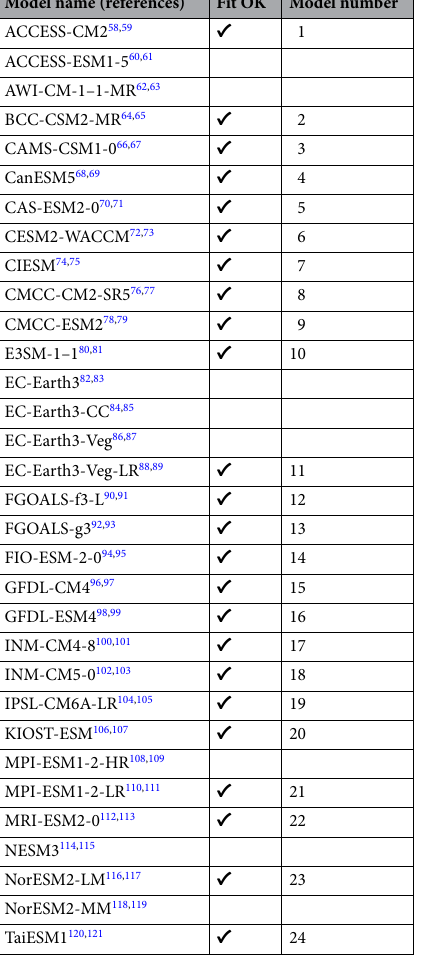
Table 1. List of CMIP6 climate models used in this study. Checkmarks indicate the climate models which are fitted by the stochastic model appropriately well. More detailed information on CMIP6 models, their components and parameterizations can be found at https:// search. es- doc.